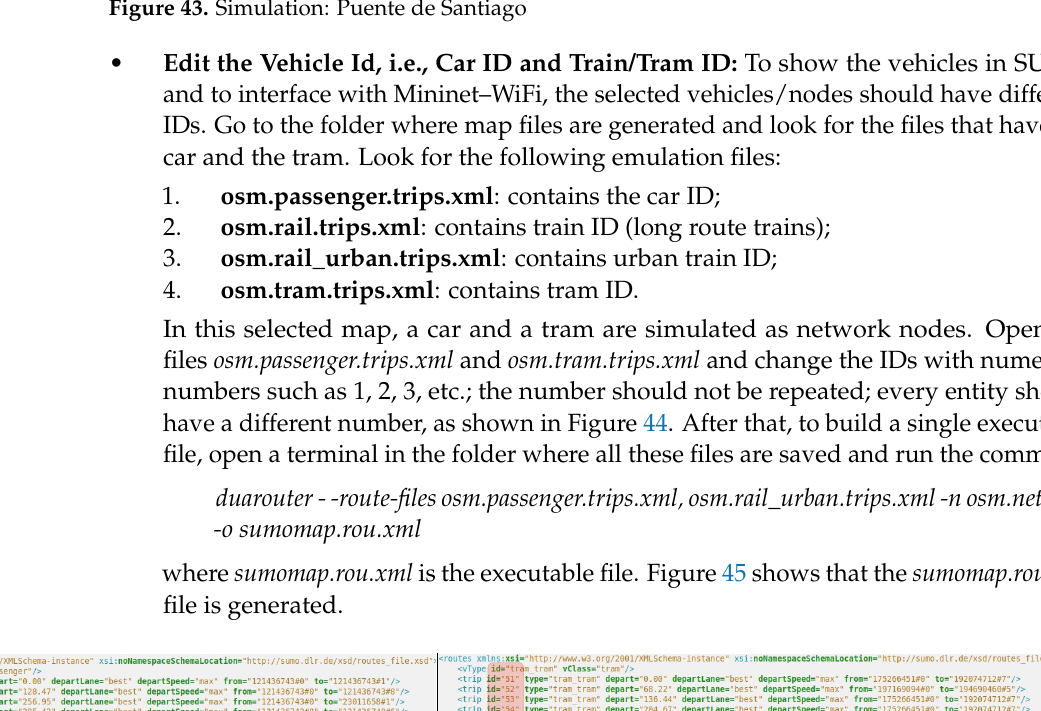
Figure 43. Simulation: Puente de Santiago